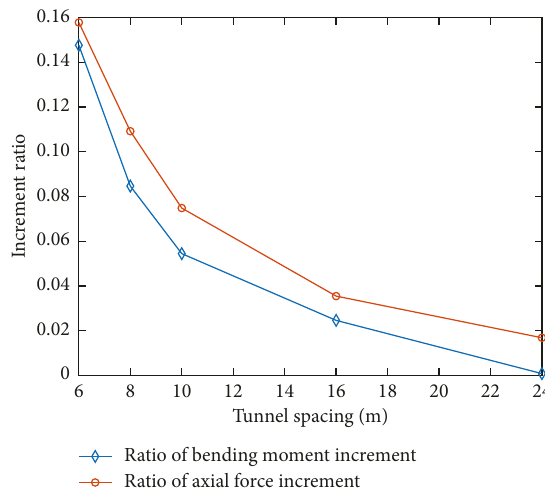
Figure 10: Ratio of internal force increment varies with